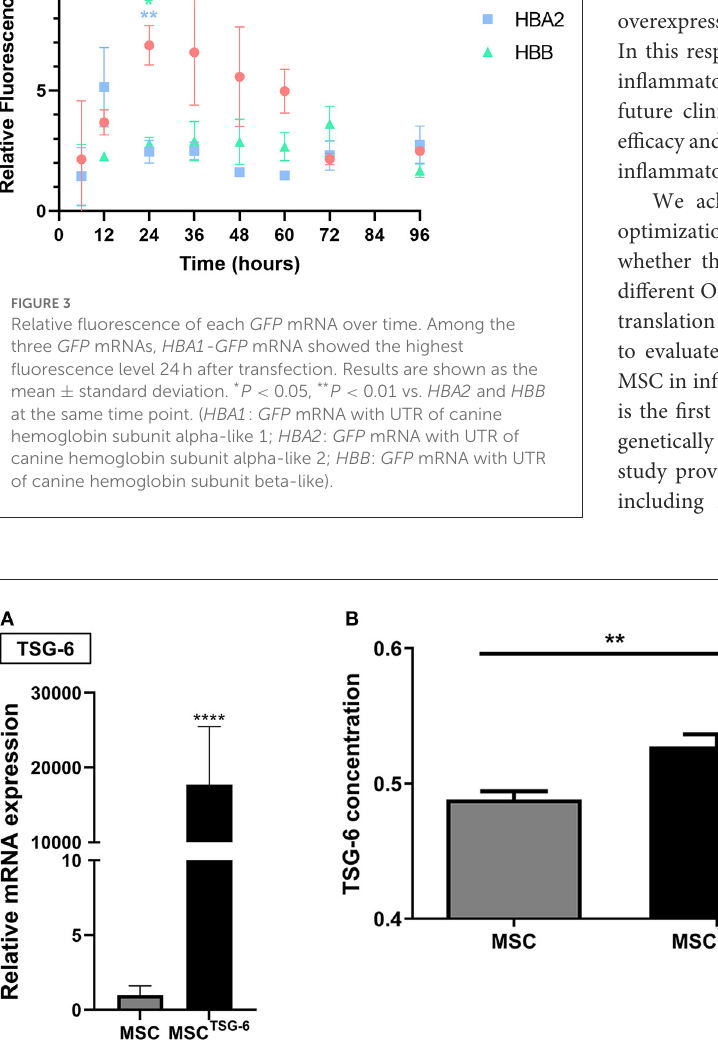
FIGURE4 TSG-6 mRNA transfection increased expression of TSG-6 in cAT-MSCs. (A) TSG-6 mRNA level was increased in cAT-MSCs transfected with TSG-6 mRNA (MSC TSG-6 ). (B) TSG-6 protein level was increased in MSCs TSG-6 . (C) Secretion of TSG-6 was also increased in MSCs TSG-6 . Results are shown as the mean ± standard deviation. ** P < 0.01, **** P <